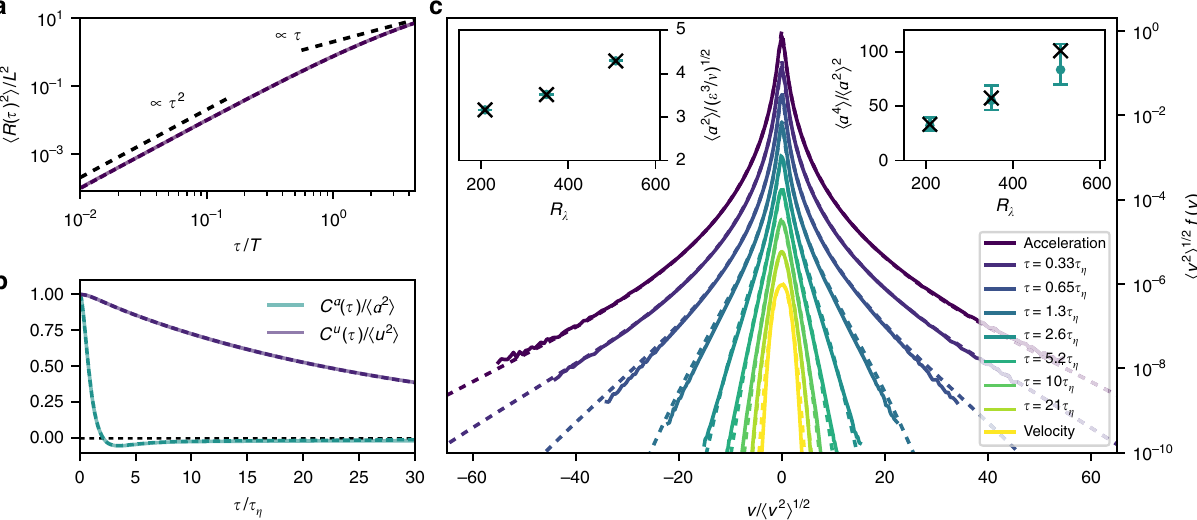
Fig. 5 Comparisons of results from the characteristic functional framework with DNS data for R λ ≈ 350. a Mean squared displacement from the model (dashed) compared to DNS data (solid), given in Eulerian integral scales L and T . The expected asymptotic ballistic and diffusive scalings are indicated for reference. b Velocity and acceleration correlation functions from the model (dashed) compared to DNS data (solid). c Comparison of PDFs derived from the model (dashed) with DNS data (solid). From top to bottom: acceleration PDF, velocity increment PDFs, velocity PDF (vertically shifted for clarity). For this comparison, we chose Θ = 3 τ η . Left inset: acceleration variance in Kolmogorov units from model (dots) compared to DNS (crosses). Right inset: acceleration fl atness from model (dots) compared to DNS (crosses). The error bars indicate variations of the coarse-graining time scale Θ between 1.5 τ η and 4.5 τ